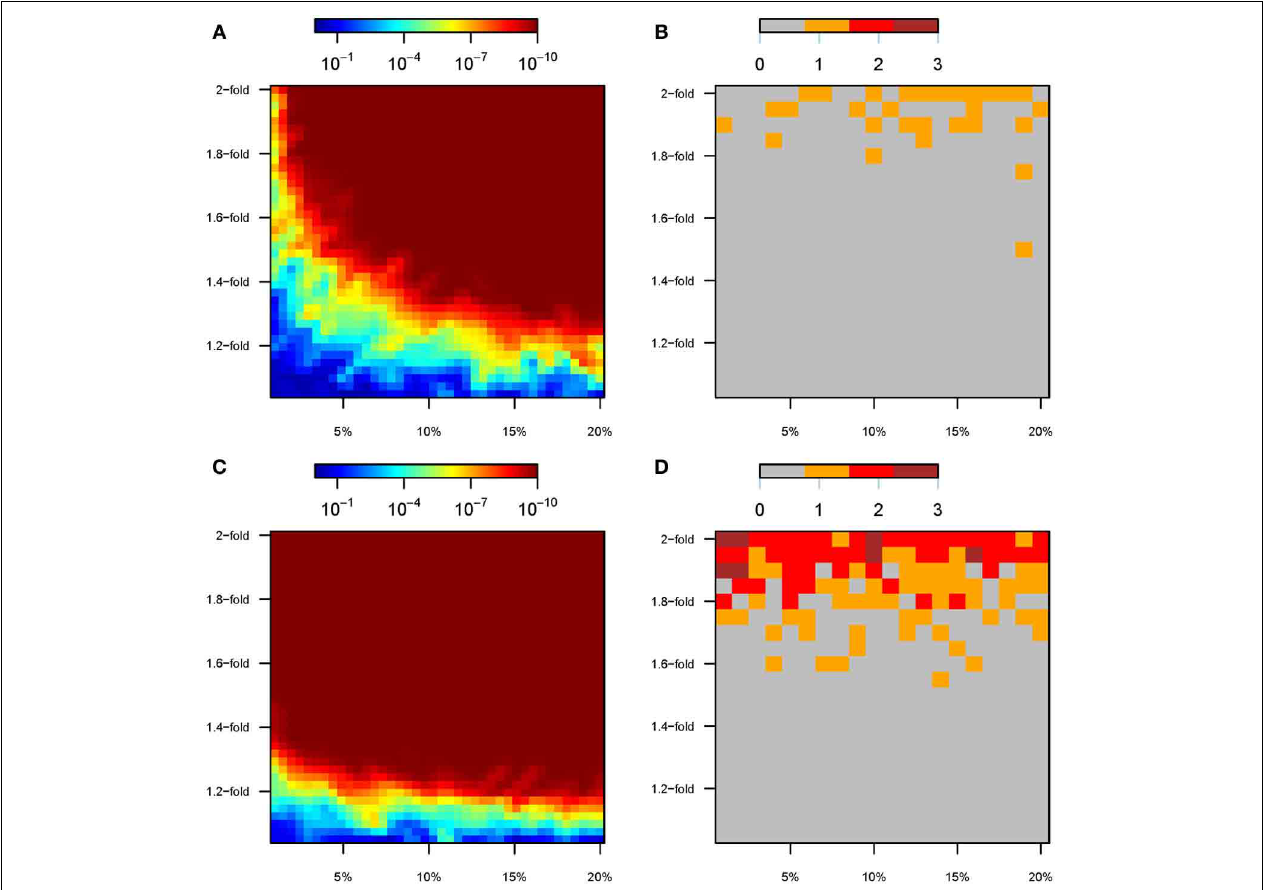
FIGURE 5 | GxE analyses under scenario A. For scenario A, color maps showing the results of the gene-by-environment interaction analyses according to the percentage of SNPs perturbed (x-axis) and the factor of perturbation in effect size (y-axis). (A) P -value of the GRSxE interaction under model 1. (B) Number of SNPs at